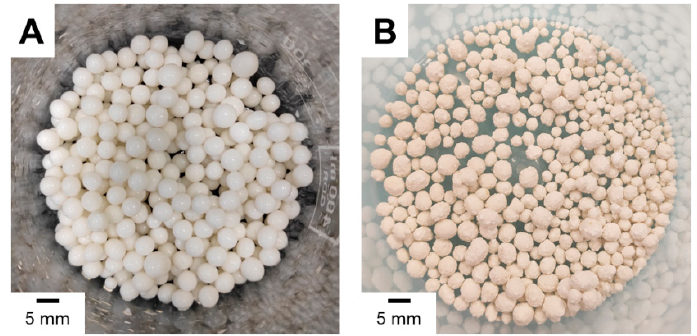
Figure 1. Optical images of representative beads before drying ( A ) and after drying ( B ). For morphological analysis, the SEM images taken from three types of beads contain- ing RAL (CS-RAL, KER-RAL and CS/KER-RAL) are shown in Figure 2. All the beads revealed a spherical shape with a rough surface. The CS-RAL beads exhibit the most heterogeneous outer surface, whereas the cross-sectional analysis indicated their relatively dense and smooth interior with numerous fine pores near the outer surface of the spheres. The keratin-containing granules (KER-RAL and CS/KER-RAL) have small indentations on the outer surface, while their graining appears to be more homogenous.